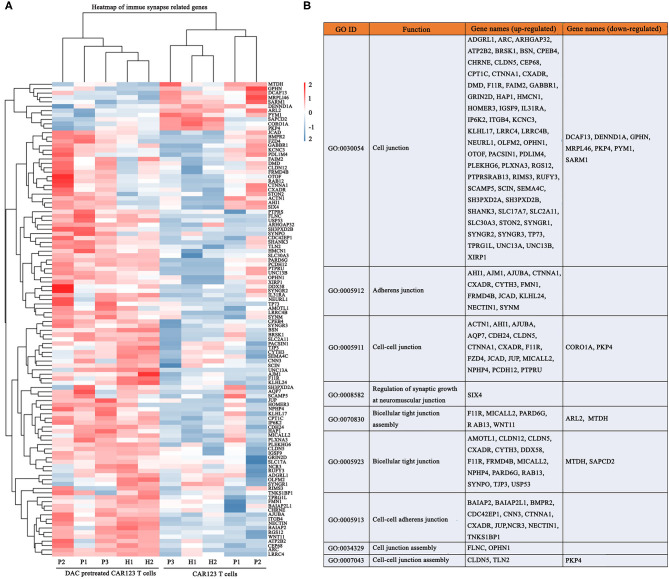
DAC enhances transcriptional signatures of immune synapse in CD123 CAR-T cells. The information of CD123 CAR-T cells and RNA seq gene expression analysis were the same as the Figure 5. (A) Immune synapse genes were presented as heat map. Each column represented an individual sample pretreated with or without DAC, and each row represented an individual gene. (B) Gene ontology (GO) enrichment of these immune synapse genes.